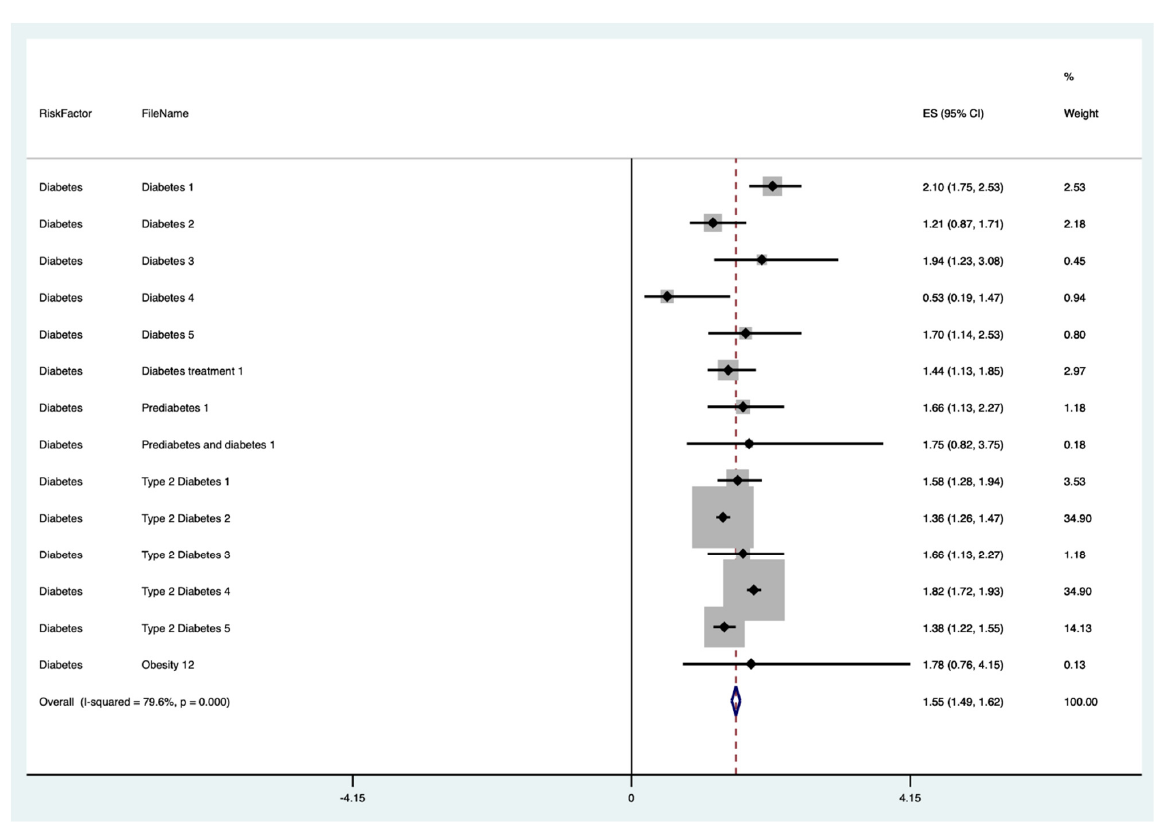
Figure 4. Forest plot to show risk of diabetes.